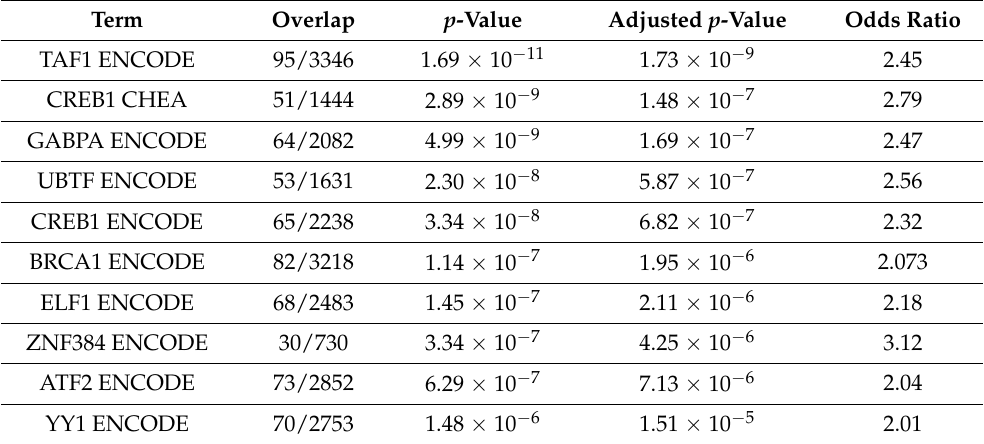
Table 5. Enriched transcription factor of the downregulated gene list from untreated RA CD8 + Temra